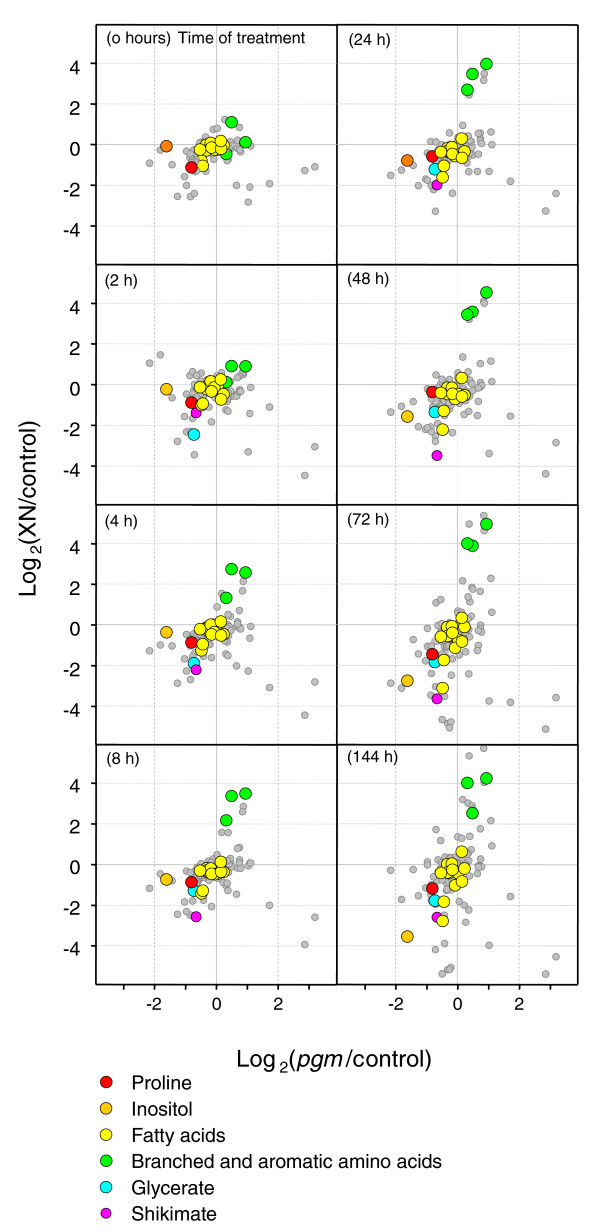
Correlation plots comparing changes in 137 metabolites in pgm to changes due to the extension of the night in WT. Colored plots correspond to the metabolites listed in the legend.